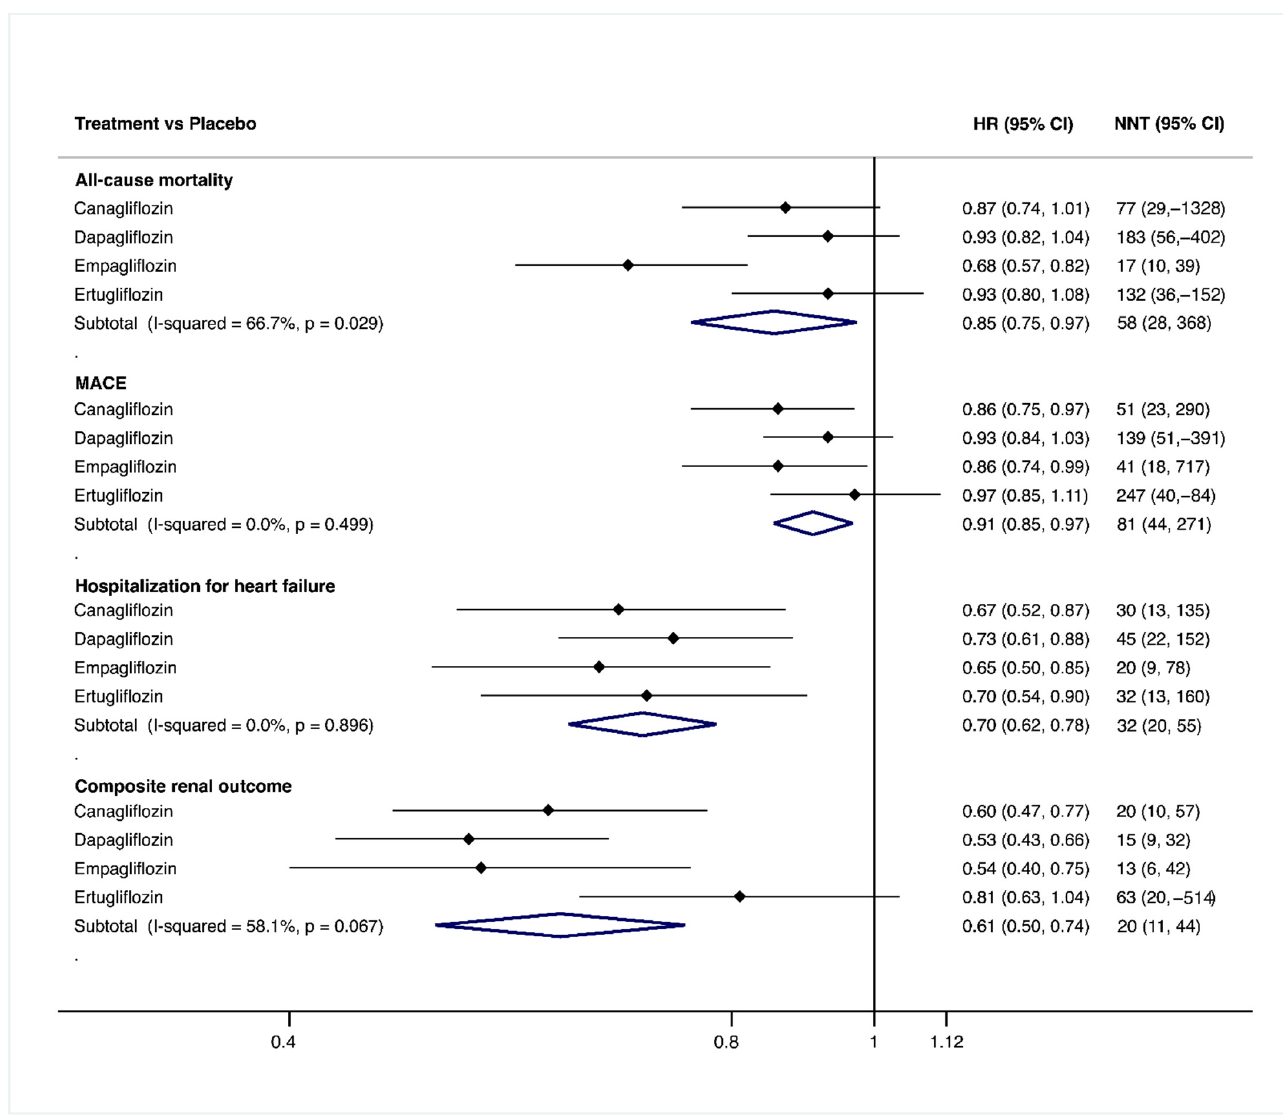
Figure 3. Forest plot for canagliflozin, dapagliflozin, empagliflozin and ertugliflozin vs. placebo to assess the efficacy of the main outcomes. Abbreviations: HR: Hazard Ratio; NNT: Number needed to treat (calculated as 1/Absolute risk reduction (ARR), with ARR = exposed incidence minus non-exposed incidence); CI: Confidence Interval; MACE: Mayor Adverse Cardiovascular Events. The HR and its 95% CI and the corresponding NNT and its 95% CI are shown. HR has been extracted from original studies and has been transformed to NNT. Positive values of NNT means the number needed to observe a benefit and negative values means the number needed to observe harm.